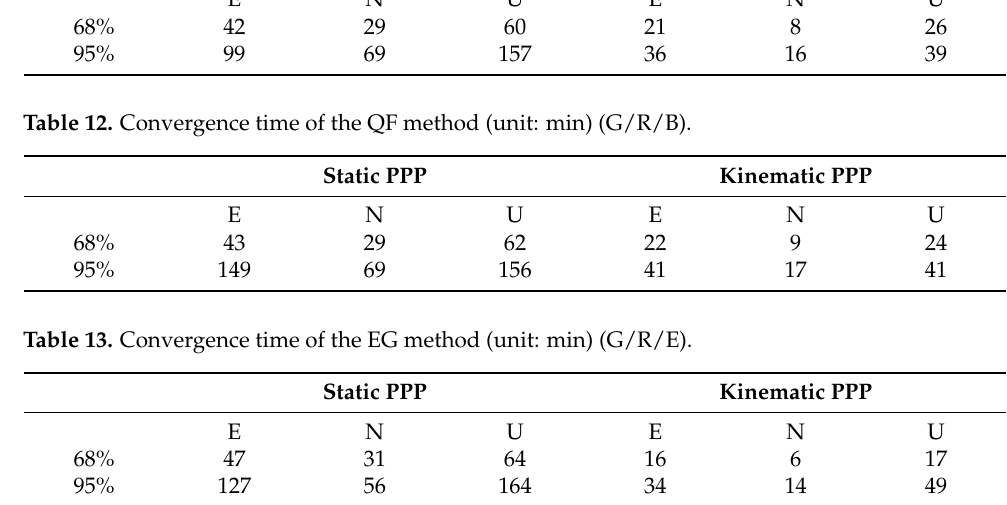
Table 11. Convergence time of the EG method (unit: min) (G/R/B). Static PPP